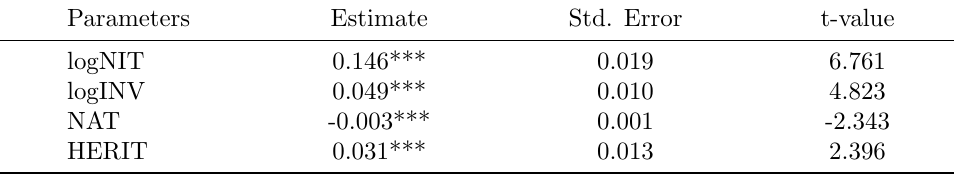
Table 1: Panel data model parameter estimates (individual effects; no spatial effects)